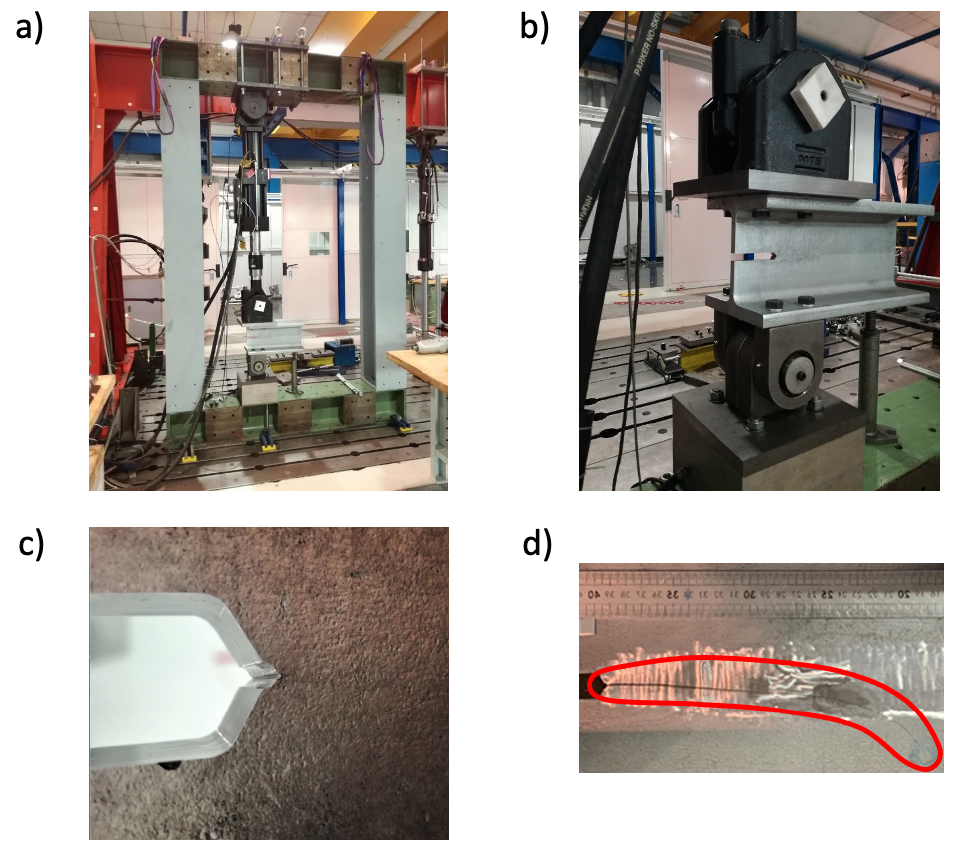
Figure 8. The experimental set up for the fatigue crack propagation test. The experimental set up for the fatigue crack propagation test. ( a ) MTS servo-hydraulic actuator, ( b ) rotational hinges, ( c ) sharp notch at the crack tip and ( d ) final path and morphology of the fatigue